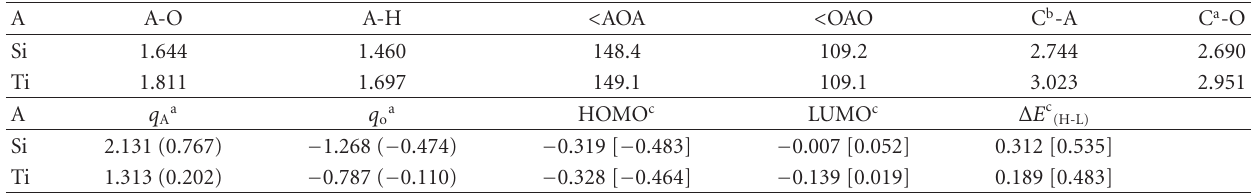
a NBO and Mulliken (in parentheses) net atomic charges on A (Si and Ti) and O atoms. b C is the center of the cage. c The HF/6-311+G(d) values are in square